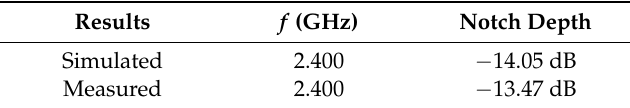
Figure 6. Simulated and measured resonance characteristics of the CCSR. Table 1. Measured and simulated results of the microwave sensor.